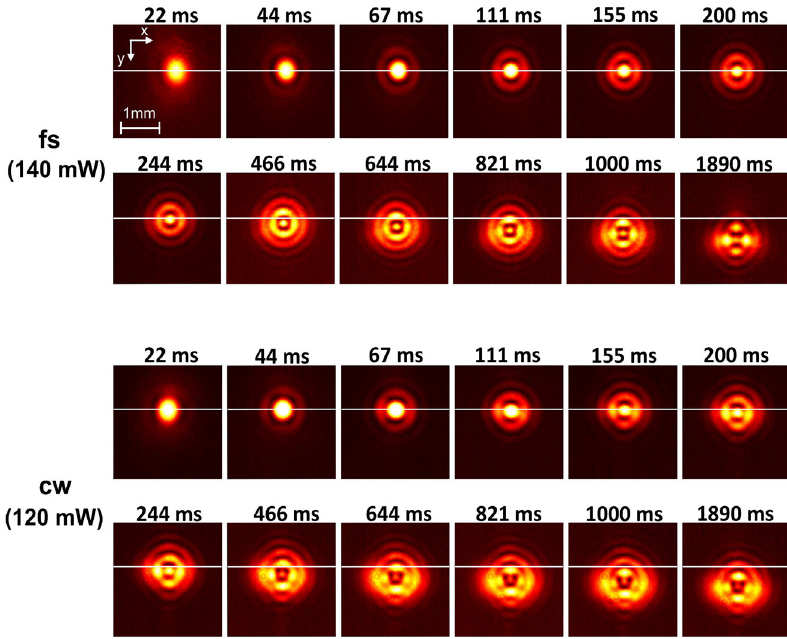
1890 ms (Suppplemental video).